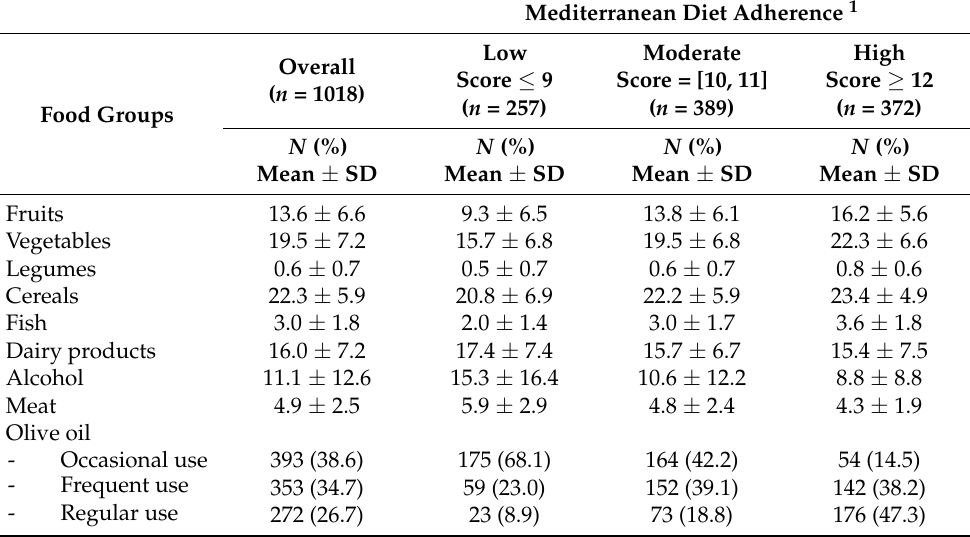
Table 2. Description of weekly food group consumption of the study sample according to adherence to the Mediterranean diet from MeDi-Lite scores ( N = 1018).